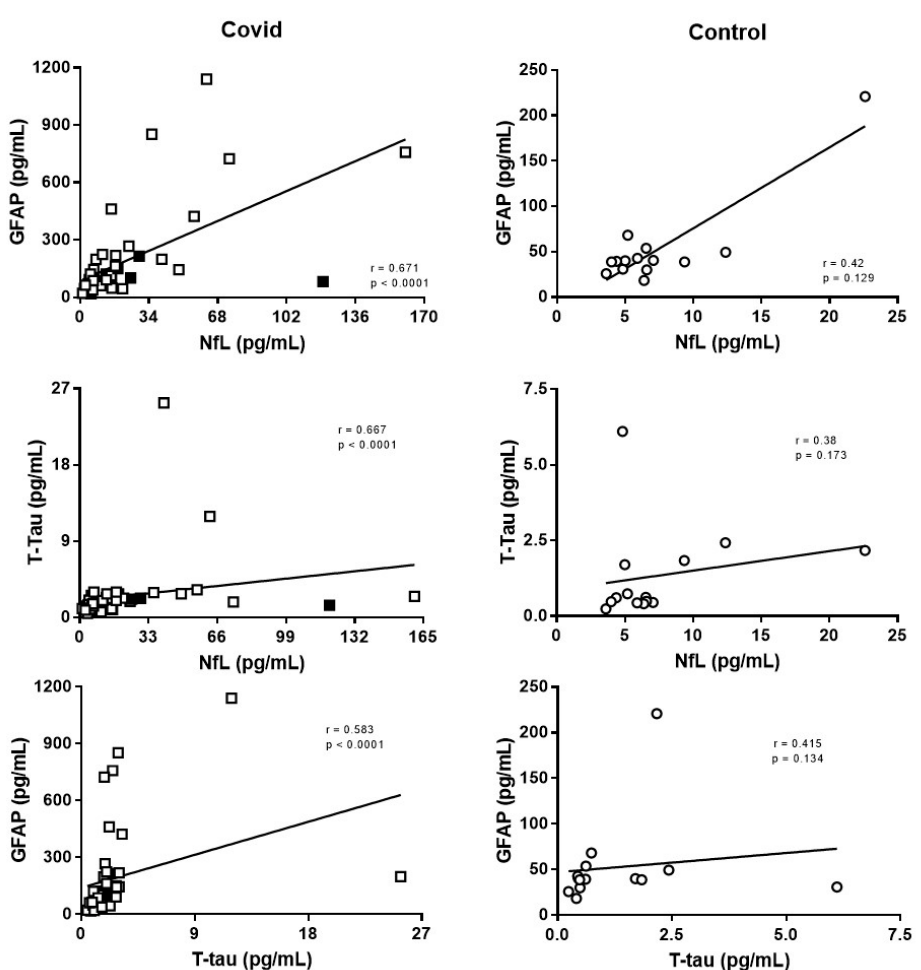
Figure 2. Correlations between plasma GFAP, T-tau and NfL levels across COVID-19 and control groups. A positive correlation was obtained when estimated levels of the biomarkers (see Figure 1) were confronted in COVID-19 in the acute phase of the disease (Covid), but not in controls. Squares: Covid; white symbol: moderate severity; black symbol: severe cases; circles: Controls. Rho (r) and p values, estimated by the Spearman test, are displayed.